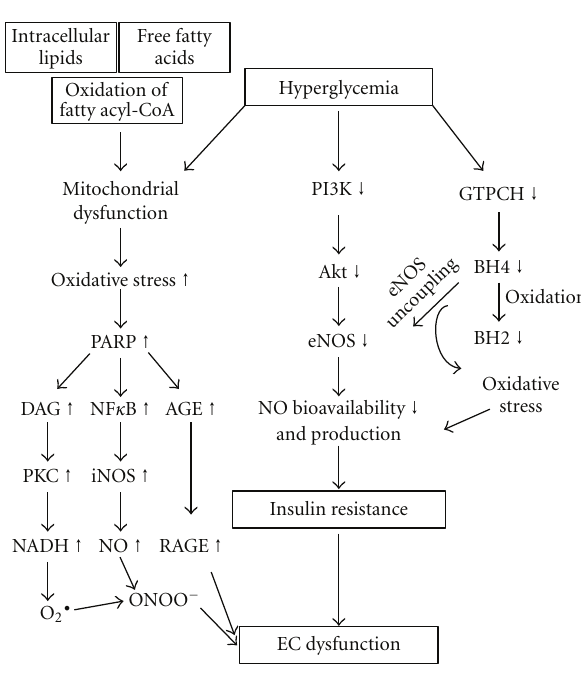
Figure 3: Signaling mechanisms leading to endothelial dysfunc- tion under diabetes. Diabetes-mediated hyperglycemia leads to multiple-signal pathway dysfunction within vascular endothelial cells. Primary insults include mitochondrial dysfunction, defective PI3 kinase signaling, decreased NO production, increased oxida- tive stress, and di ff erential PKC isoform activation. Key words: pARP: poly (ADP-ribose) polymerase; AGE: advance